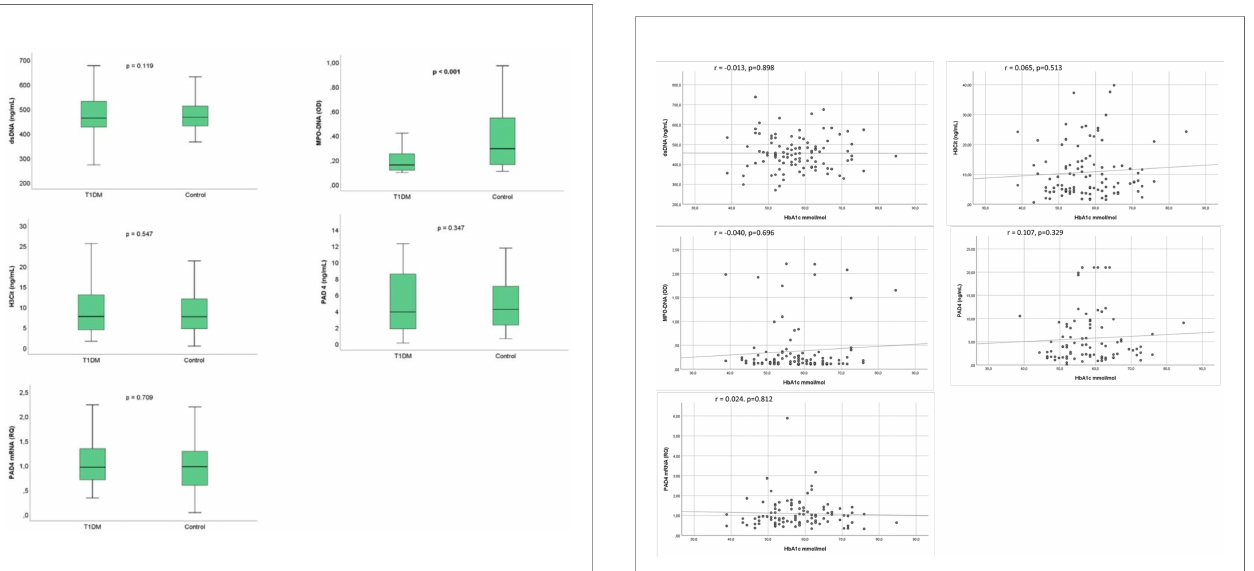
FIGURE 2 | Correlations between NETs markers and current HbA1c in T1DM. Scatter graphs with trend line showing correlations between markers of NETs and HbA1c in TIDM. T1DM, type 1 diabetes mellitus; dsDNA, double-stranded deoxyribonucleic acid; MPO-DNA, myeloperoxidase-DNA; H3Cit, citrullinated histone 3; PAD4, peptidylarginine deiminase